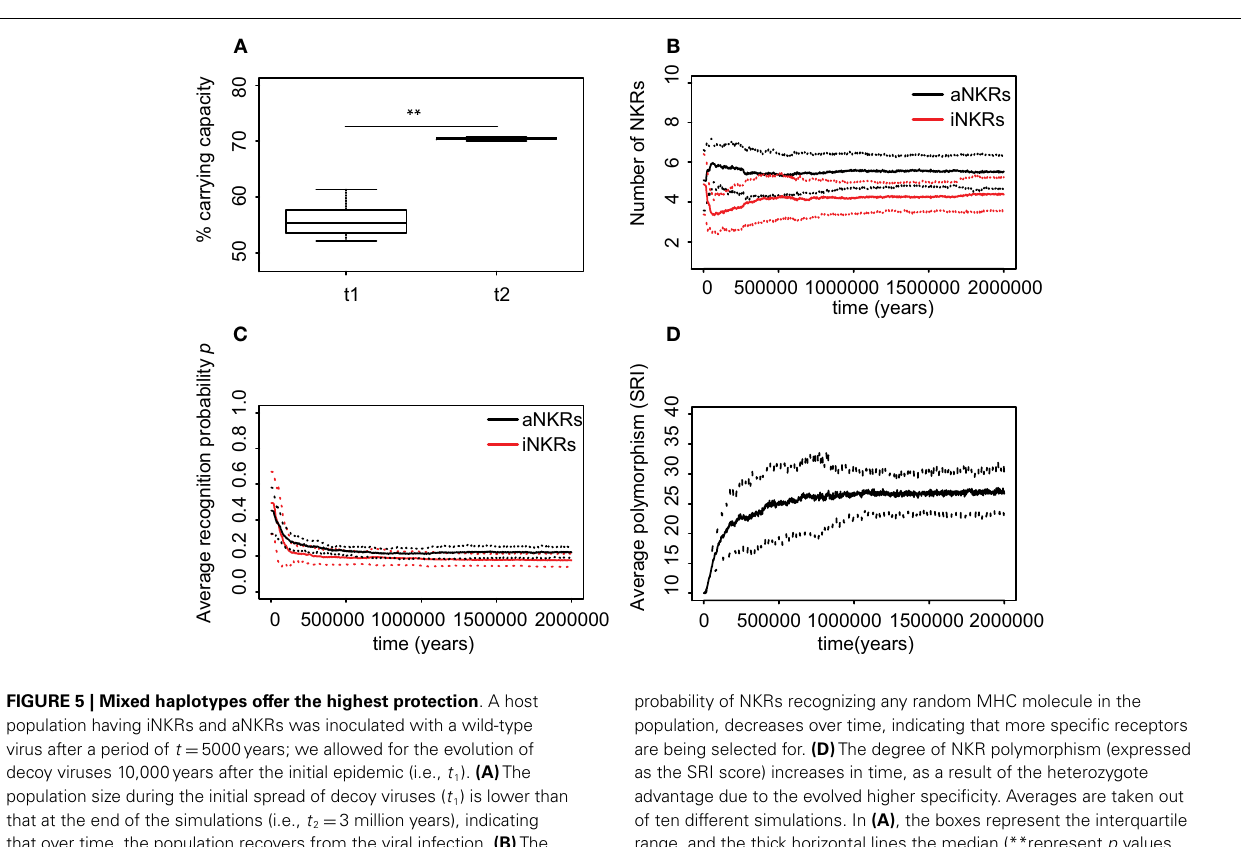
FIGURE 5 | Mixed haplotypes offer the highest protection . A host population having iNKRs and aNKRs was inoculated with a wild-type virus after a period of t = 5000years; we allowed for the evolution of decoy viruses 10,000years after the initial epidemic (i.e., t 1 ). (A) The population size during the initial spread of decoy viruses ( t 1 ) is lower than that at the end of the simulations (i.e., t 2 = 3 million years), indicating that over time, the population recovers from the viral infection. (B) The initial haplotype is composed of five iNKRs and five aNKRs.The number of aNKRs and iNKRs per haplotype varies over time, resulting in a selection for haplotypes with a larger activating potential. (C) The